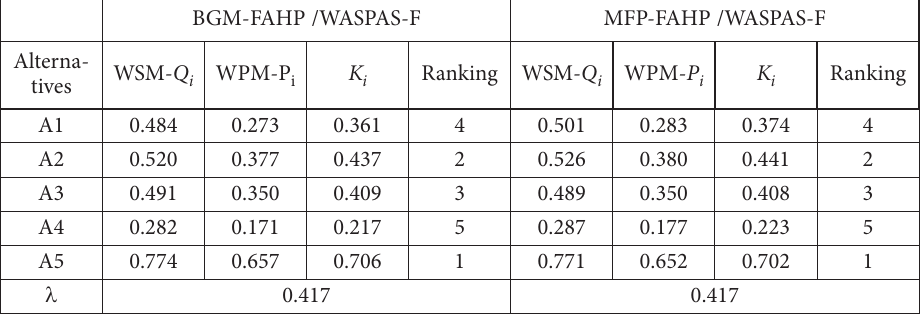
Table 9. Results of the integrated FAHP/WASPAS-F